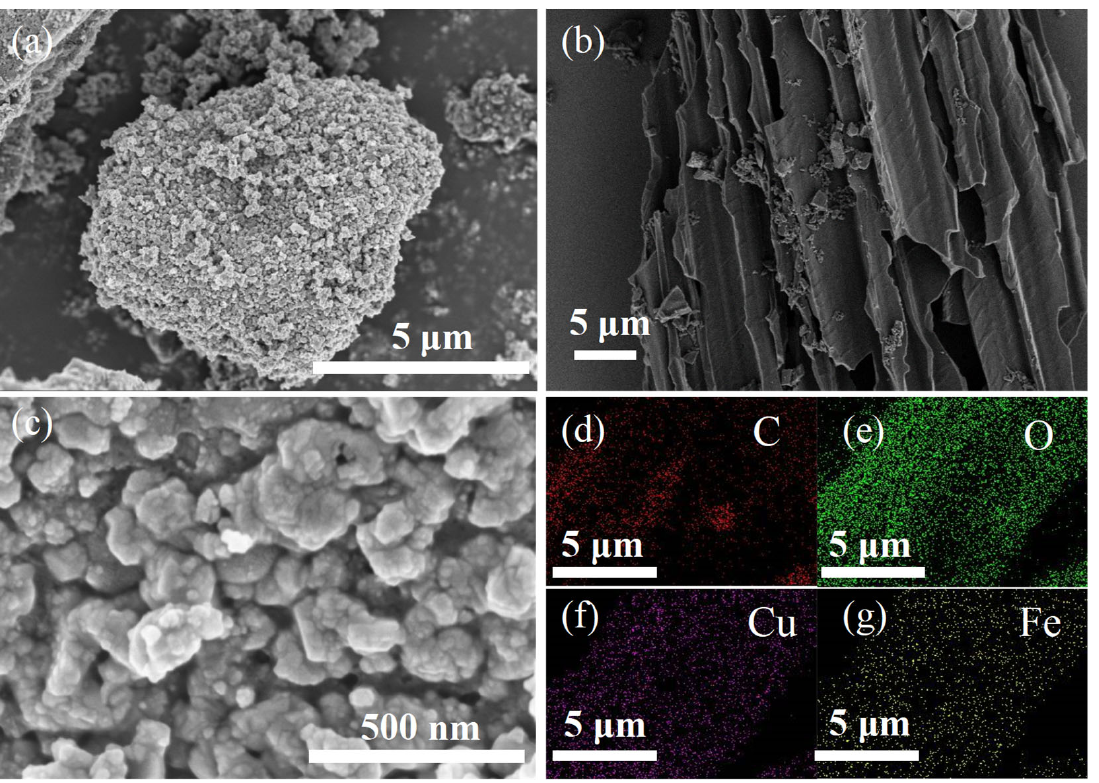
Figure 1. ( a , c ) SEM images and ( d – g ) EDS mapping images of the CuFe 2 O 4 @BC catalyst, ( b ) SEM images of BC catalyst.